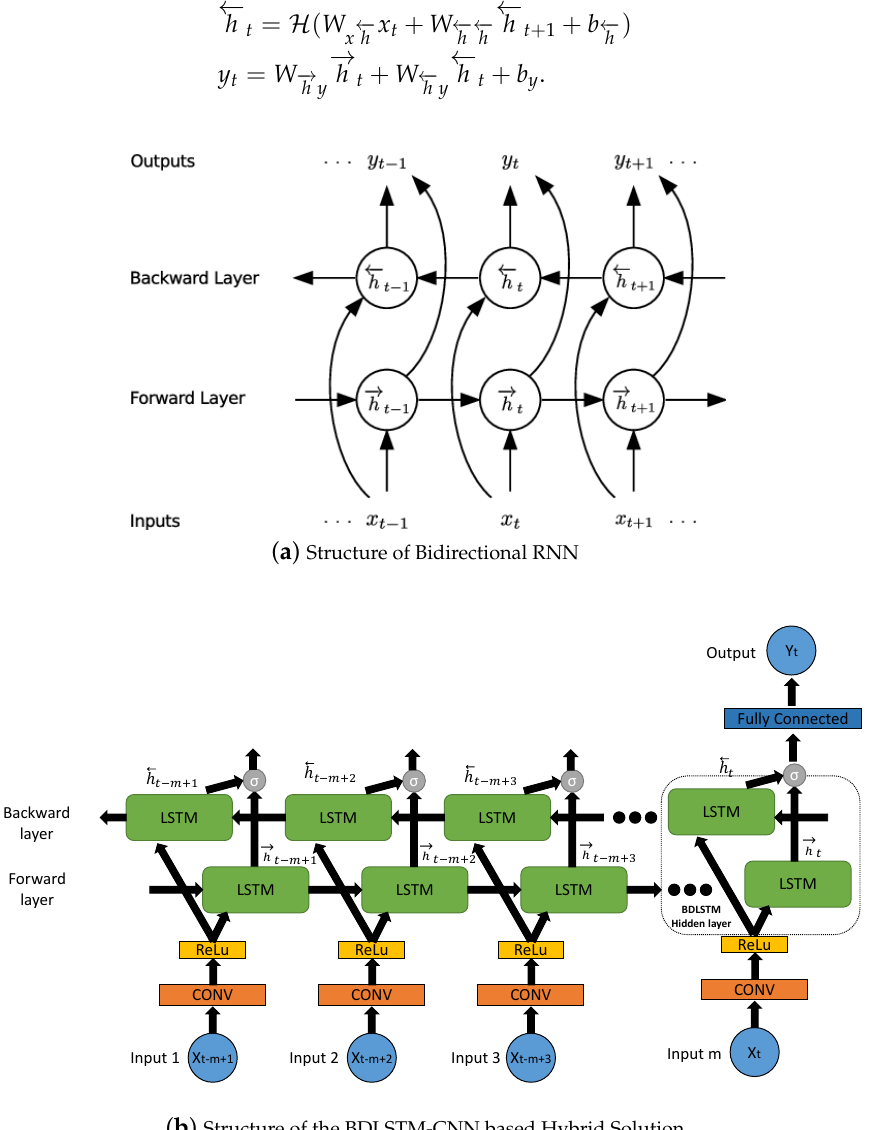
Figure 4. Structure of Bidirectional RNN, and the Hybrid